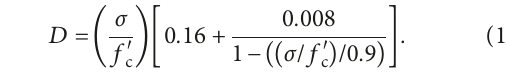
Figure 10: Damage index versus sustained stress in nonlinear creep